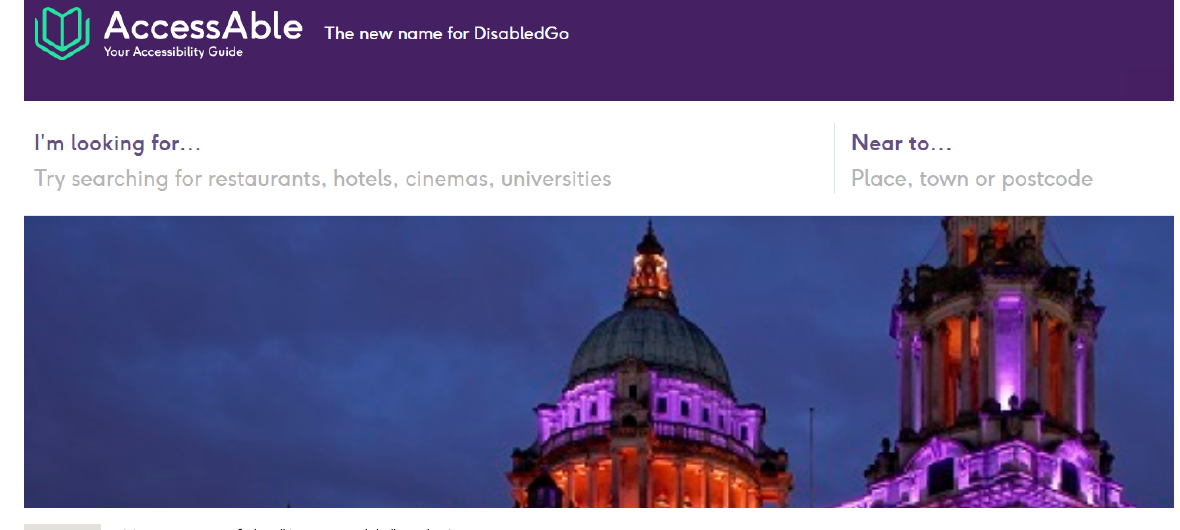
Homepage of the “Access-able”